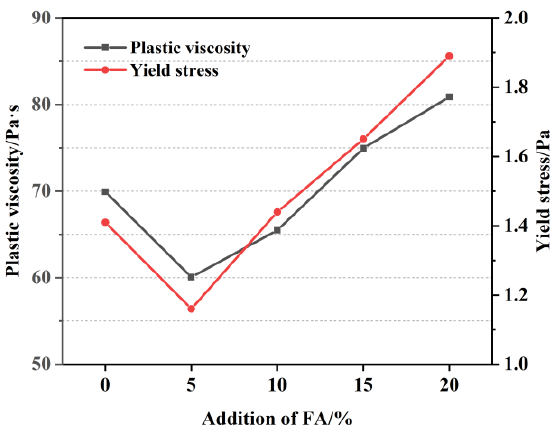
Figure 7. MPC rheological properties with different contents of FA.